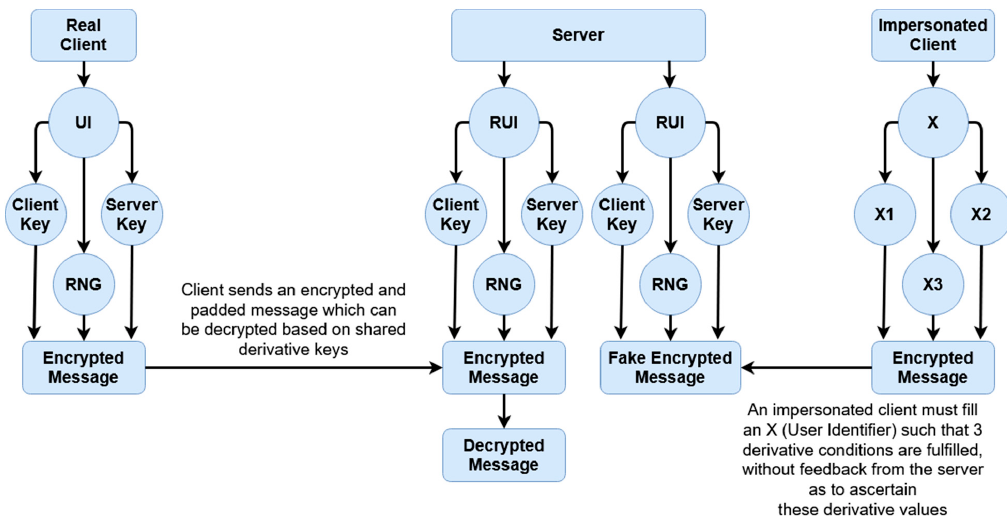
Figure 11. A masquerade attack under TFHVA scheme.